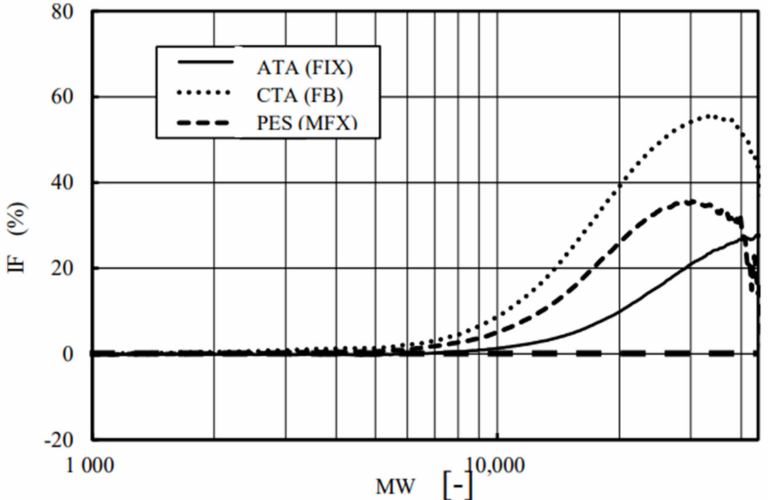
Figure 10. Relationship between the index for fouling (IF) and MW. Forward (In-to-Out) filtration ( n =